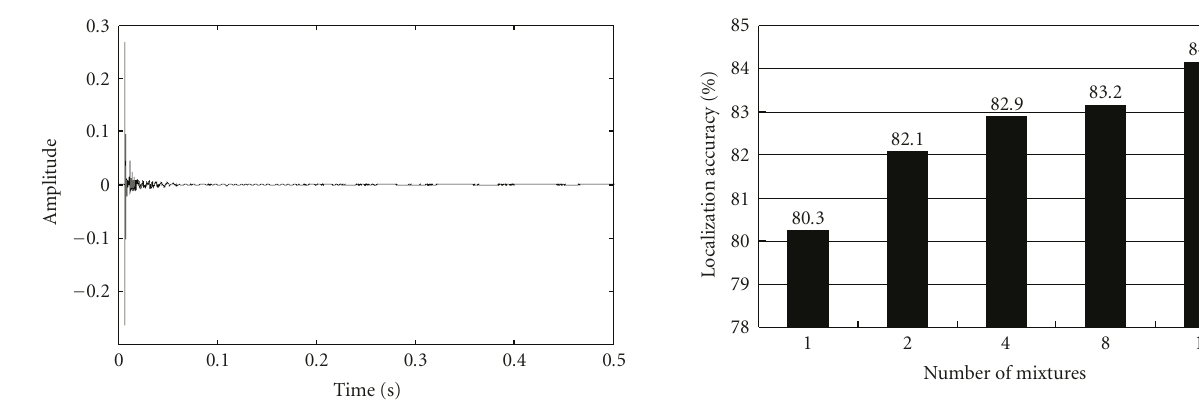
Figure 6: E ff ect of increasing the number of mixtures in modeling acoustic transfer function, here, 50 words are used for the estimation of the acoustic transfer function.